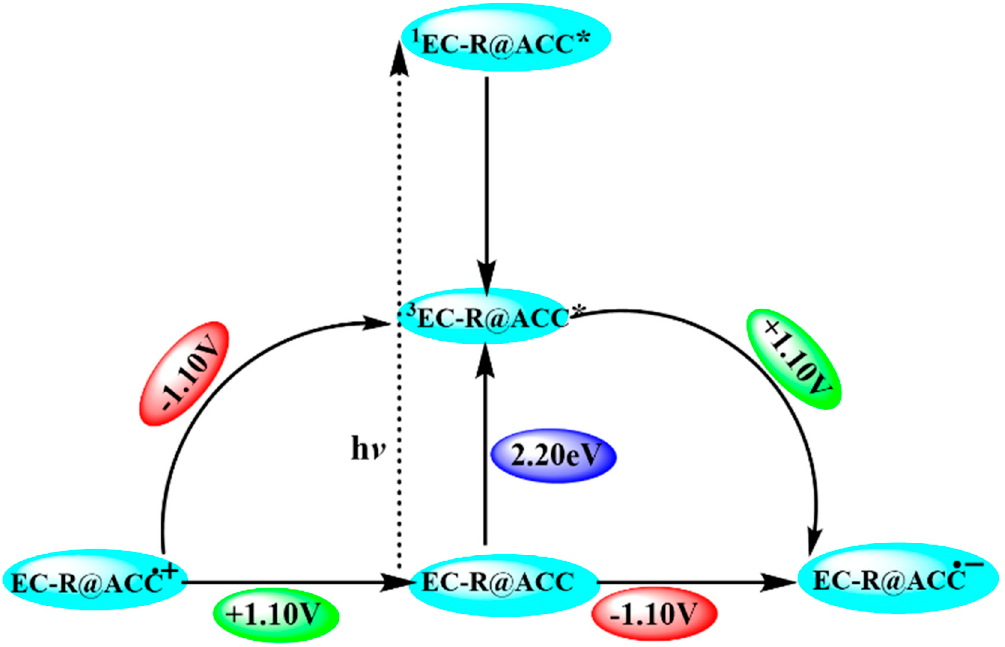
Figure 4. Latimer Diagram displaying the photo-redox property of the EC-R@ACC photocatalyst; ( * represent the excited state. )